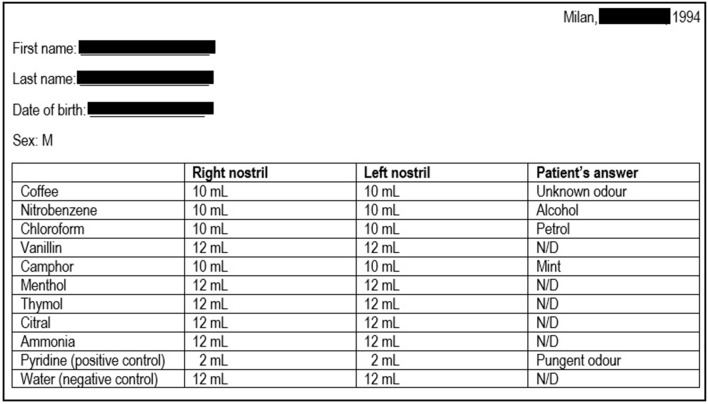
Results of the sniff test performed at patient's first referral. The first column indicates the 10 odorants employed; the second and the third columns indicate the minimum amount of each substance that the patient was able to detect on the right or left nostril, respectively (first threshold); in normal individuals, the first threshold is generally <3 mL. The patient was also asked to identify the substances, and the patient's answers are reported in the last column. The results are consistent with a severe smell defect. N/D, not detected.